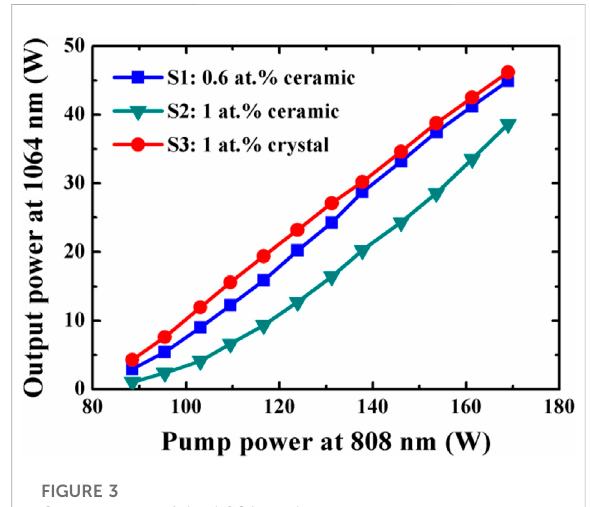
FIGURE 3 Output power of the 1,064-nm laser versus pump power at 808